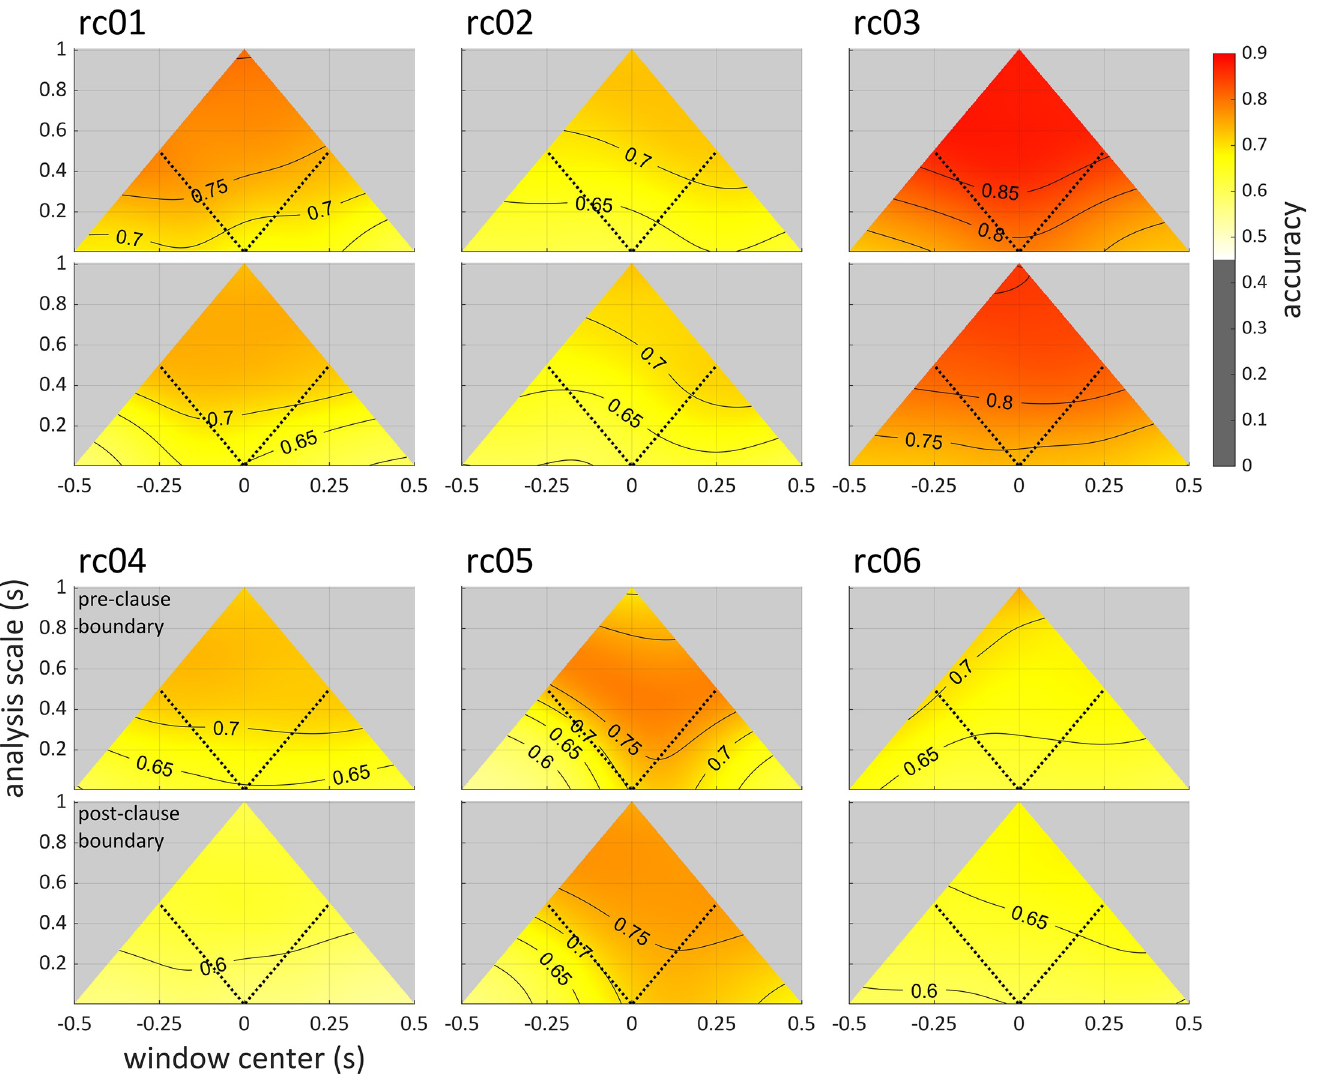
Fig 8. Accuracy scalograms for all speakers in the relative clause dataset. Scalograms are smoothed and interpolated. The alignment points (time 0) are the pre- and post-clause boundaries, for example: A Mr . Hobb | pre who know Mr . Rodd | post often plays tennis . The dotted lines in each panel show the centers of windows whose edges align with the